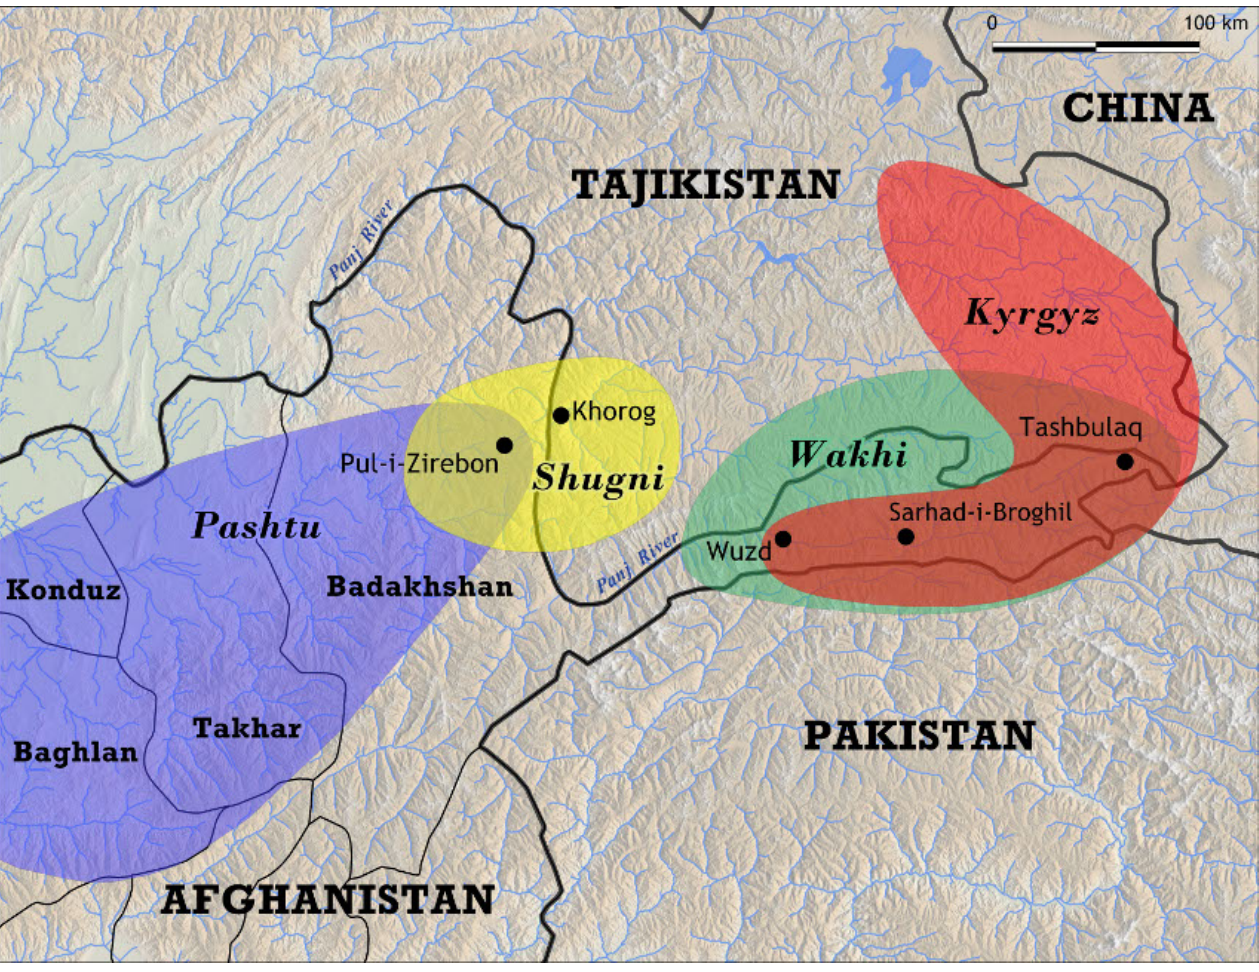
Fig. 2 . Map of ethnic groups in the Pamir Mountains of Afghanistan (and Tajikistan) in Central